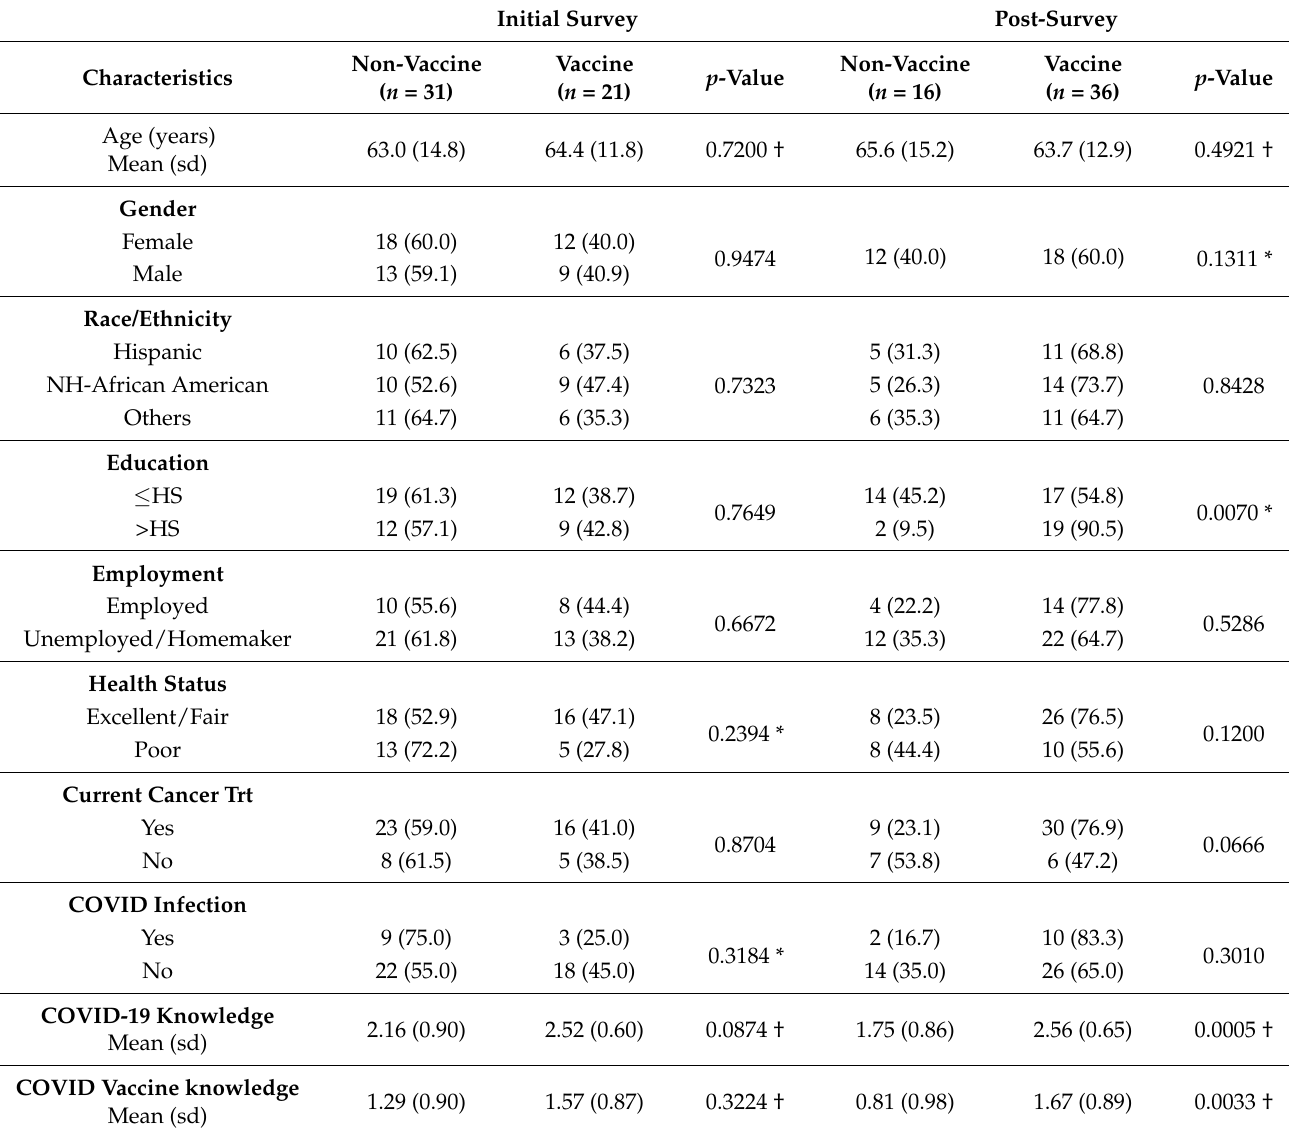
Table 1. Distribution of patient characteristics by vaccination status (Initial and